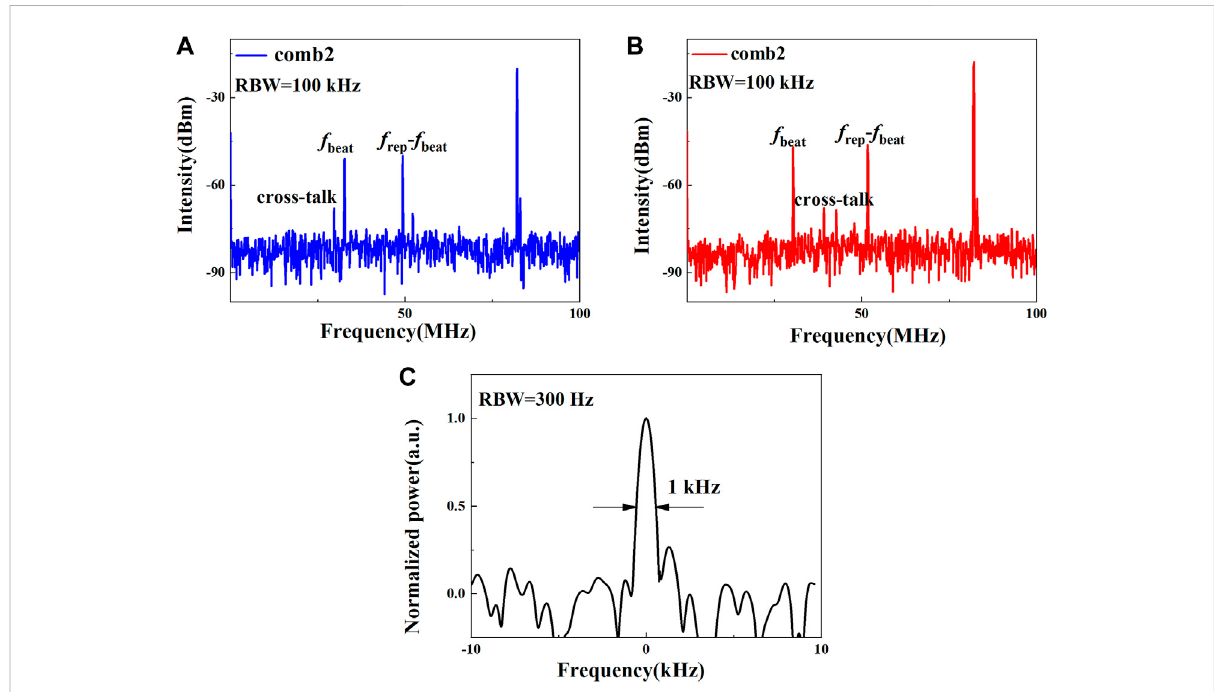
FIGURE 4 Beat notes between the narrow-linewidth continuous wave laser and (A) comb1, or (B) comb2 (C) Relative beat note between the two frequency combs at 1,555.5